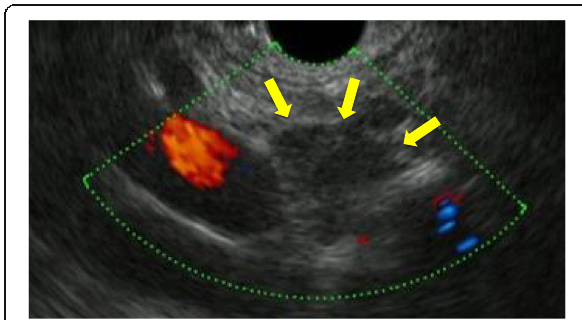
Fig. 2 Endoscopic ultrasonography image of the nodule. An endoscopic ultrasonography shows a hypoechoic lesion without vascular flow. The margin of the lesion was slightly indistinct